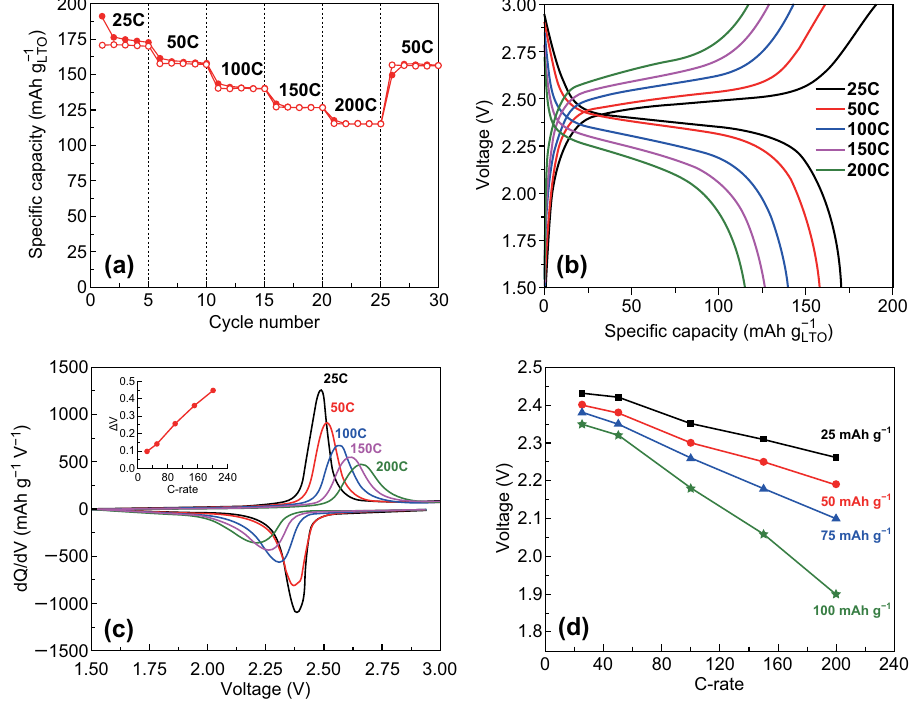
Fig. 4 Electrochemical performances of the full cells. a Rate performance of the aged LTO/LMO full cell at high rates of 25 C to 200 C . b First- cycle charge–discharge profile of the fabricated aged LTO/LMO full cell. c d Q d V −1 plots of the full cell at different rates (the inset shows the voltage polarization as a function of the C -rate). d Measured discharge voltages at different rates and different states of discharge corresponding to 25, 50, 75, and 100 mAh g